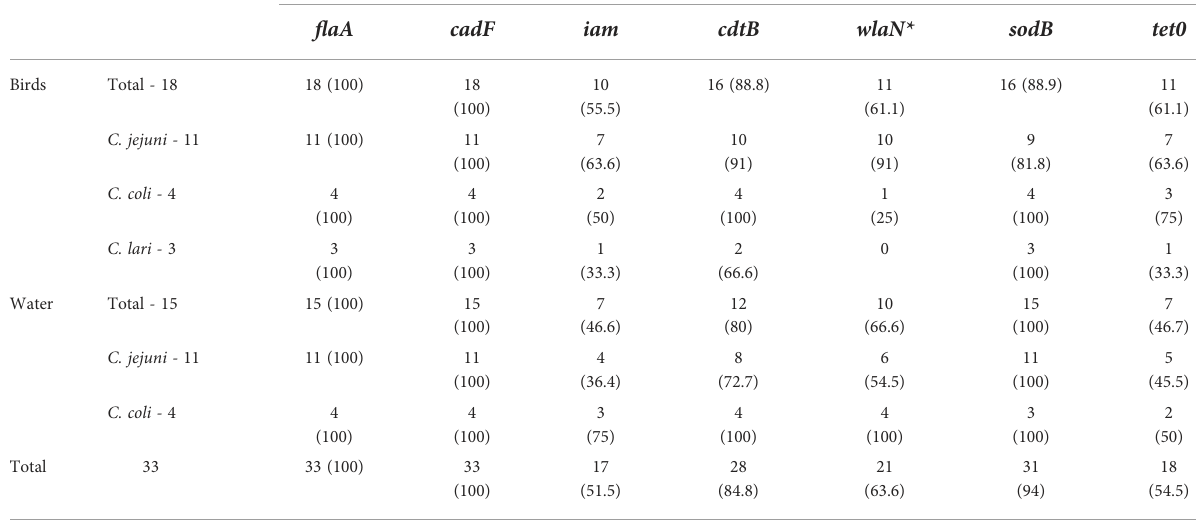
TABLE 3 Distribution of virulence genes in Campylobacter spp. isolated from environmental sources.